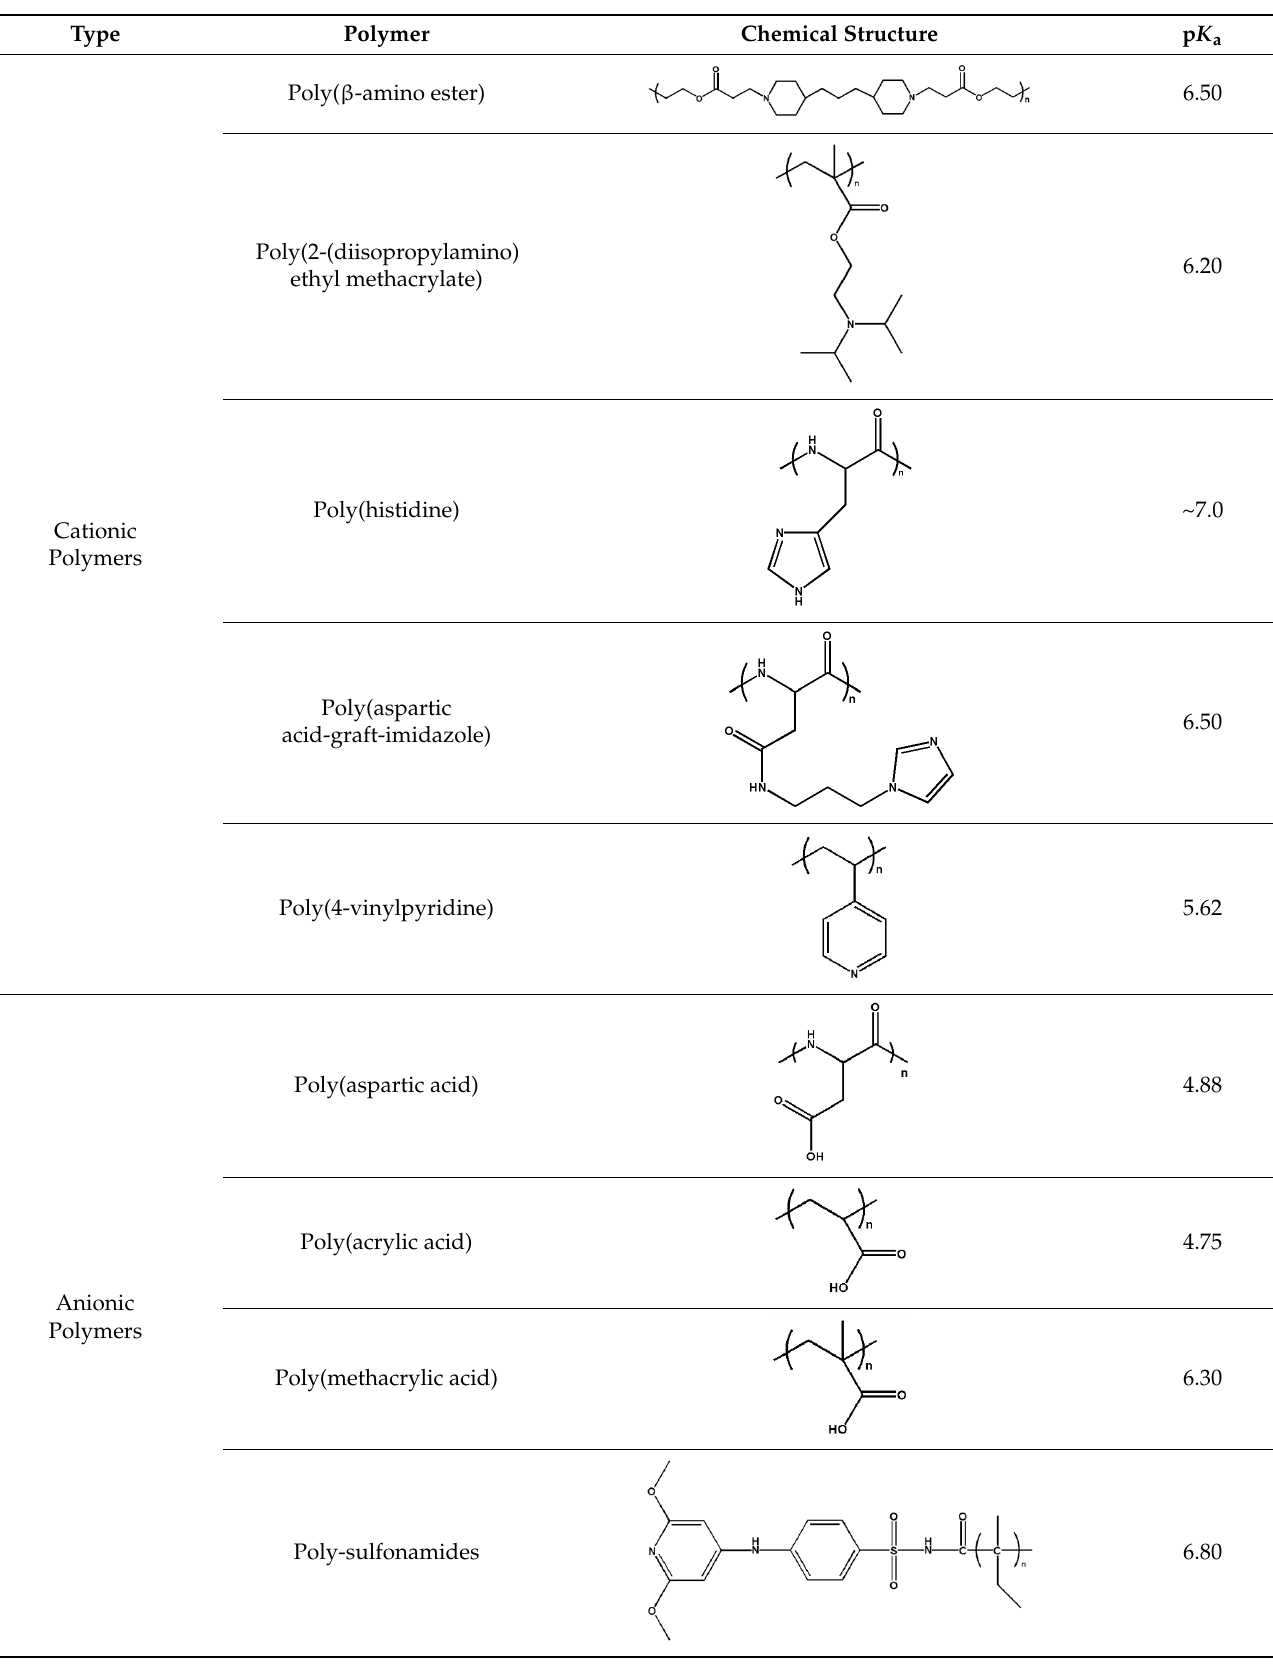
Table 2. Examples of pH-sensitive cationic and anionic polymers.